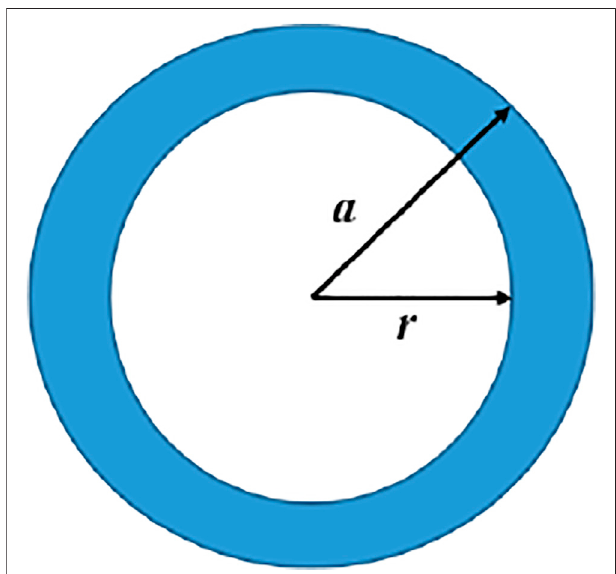
FIGURE 4 | The RVE for the random distribution pattern.